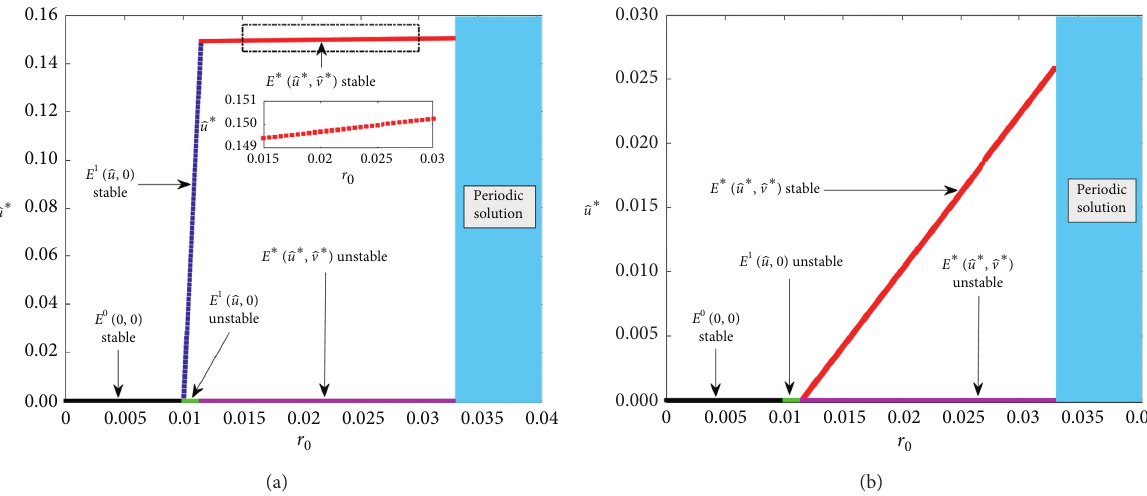
Figure 13: Bifurcation diagram with respect to the growth rate r dington–DeAngelis response function. Other parameter values are specified as δ ξ � 0 . 30. The dash-dotted box is zoomed in the inset, which shows the increasing trend of the stable branch of the interior steady state E ∗ ( 􏽢 u ∗ , 􏽢 v ∗ )